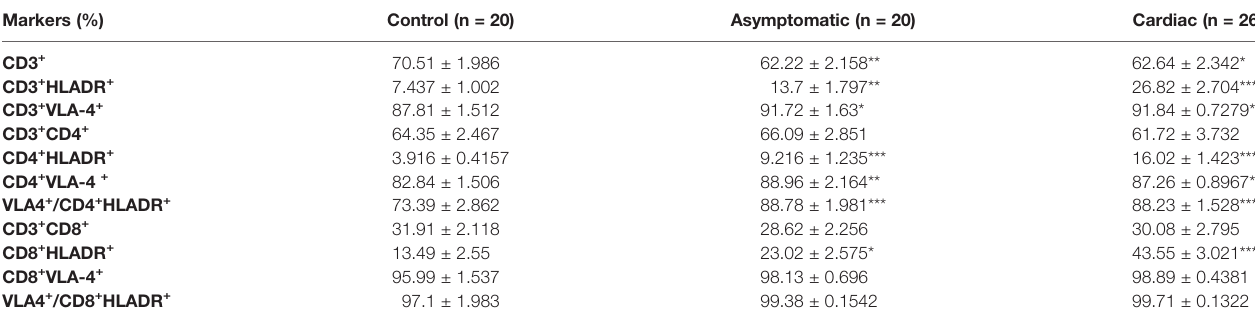
Values are expressed as mean ± SEM. *p < 0.05, **p < 0.01, and ***p < 0.005; ****p < 0.001 versus Control